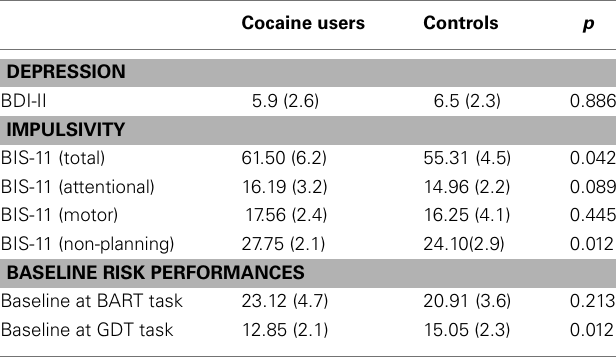
Table 3 | Group mean total scores ( ± SD) and comparisons ( t -test) of depression, impulsivity, and baseline performances (absolute first trial) at risk tasks